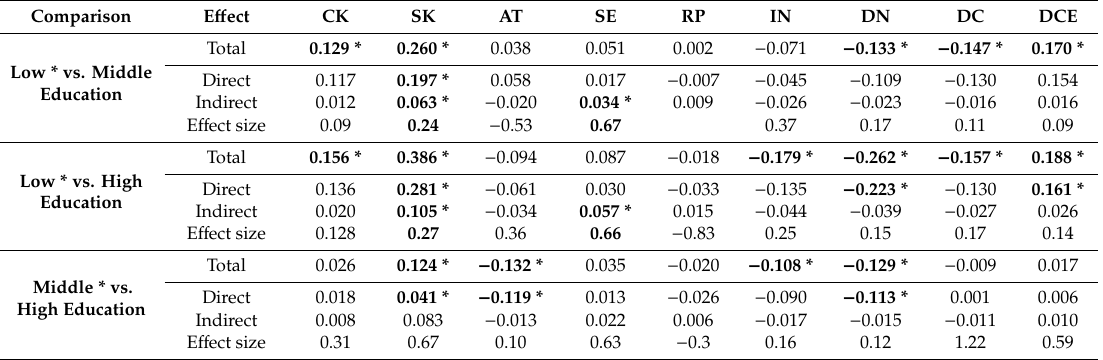
Table 4. Standardized total, direct and total indirect: mediator Numeracy